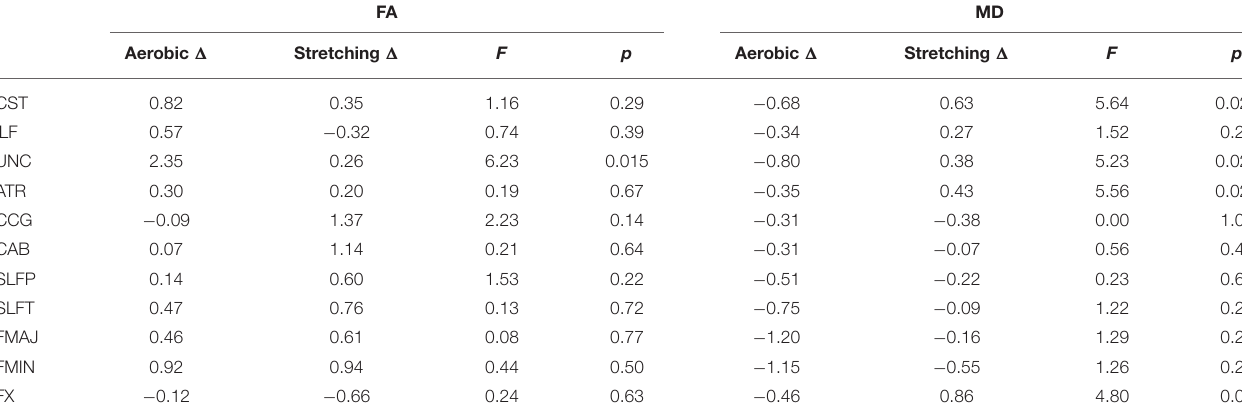
TABLE 2 | Intervention effect on the white matter tract microstructural in terms of mean percentage